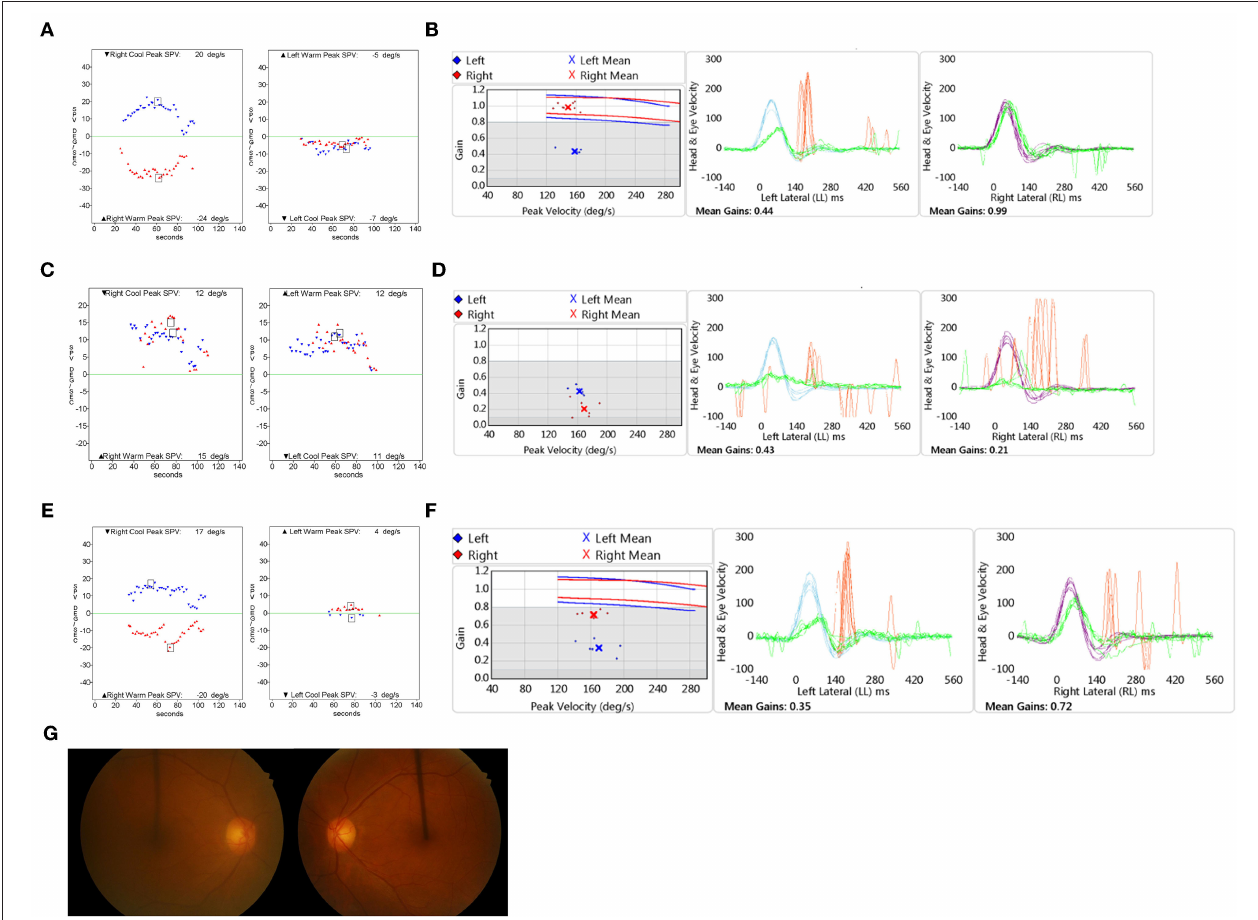
FIGURE 2 | Clinical assessment of Case 2. The bithermal caloric test (A) and video head impulse test (vHIT) (B) results show unilateral vestibular hypofunction when the patient was diagnosed with left vestibular dysfunction initially. The bithermal caloric test (C) and vHIT (D) results show bilateral vestibular hypofunction when the patient was diagnosed with right vestibular dysfunction. The bithermal caloric test (E) and vHIT (F) performed 1 year later revealed partial recovery of the right side. (G) Fundus photography showed symmetric ocular torsion. vHIT: video head impulse